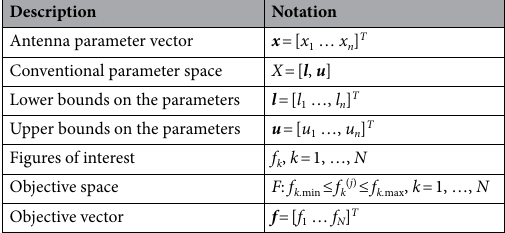
Table 1. Notation used in performance-driven